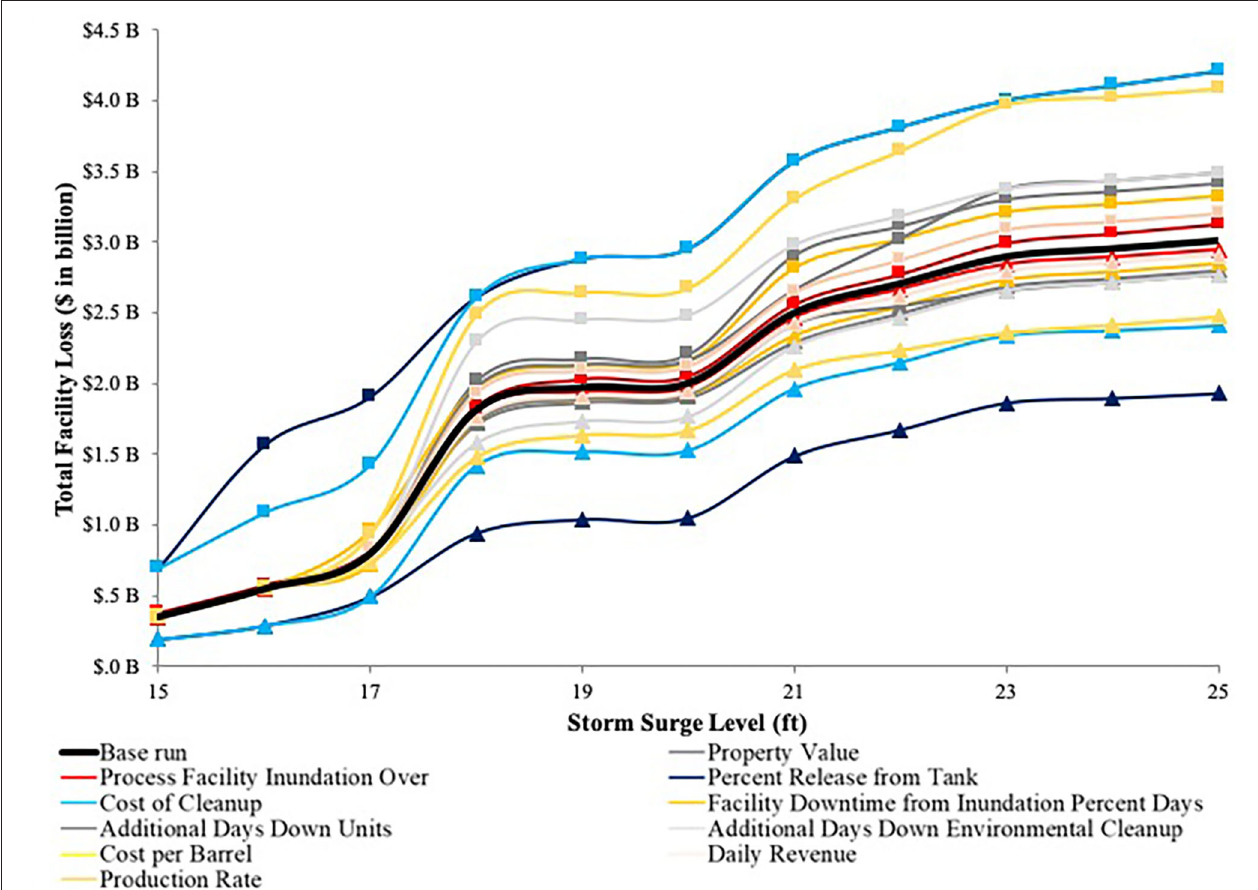
FIGURE 11 | FEDERAP sensitivity analysis results for Facility A. Lines with squares and triangles represent doubled and halved scenarios,